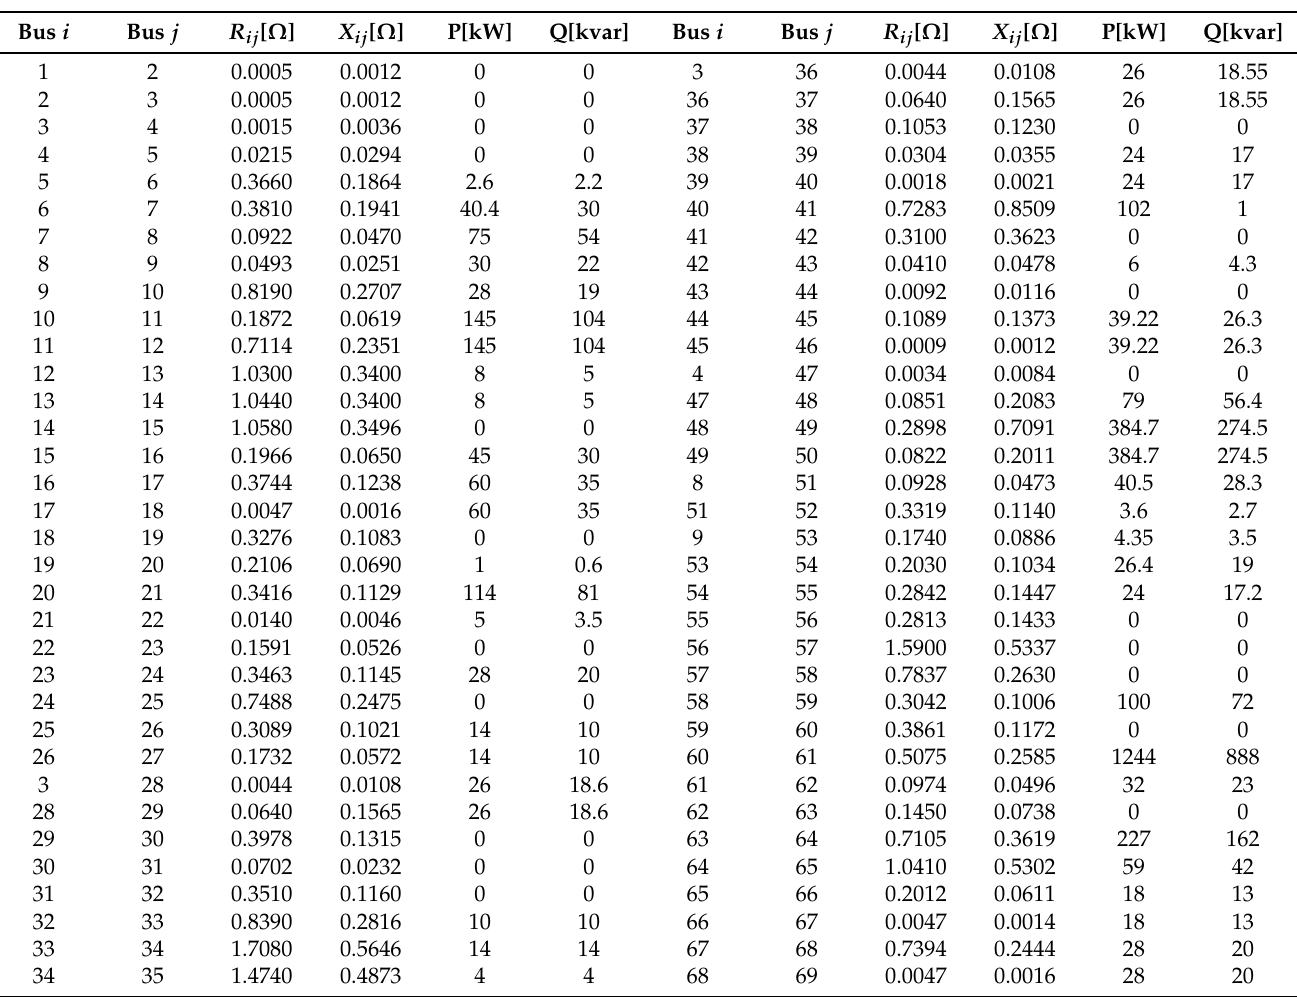
Figure 6. Electrical diagram of the 69-bus test system. Table 3. Parameters of the 69-bus test